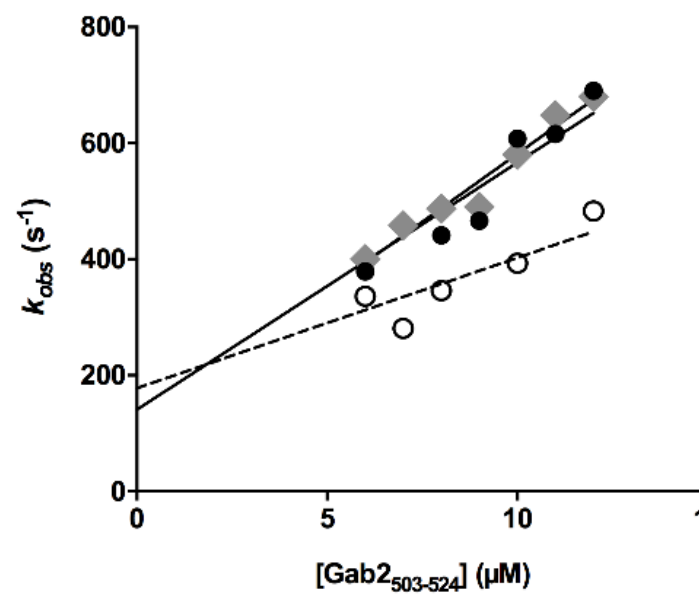
Figure 4. Observed rate constants measured through stopped-flow kinetic binding experiments by rapidly mixing a constant concentration of C-SH3 versus different concentrations of Gab2* in absence (full circles) and in presence of 5 μ M AN-465-J137-985 (empty circles). The data recorded in the absence of DMSO and AN-465-J137-985 are reported in gray diamonds. Lines are the best fit to a linear equation.